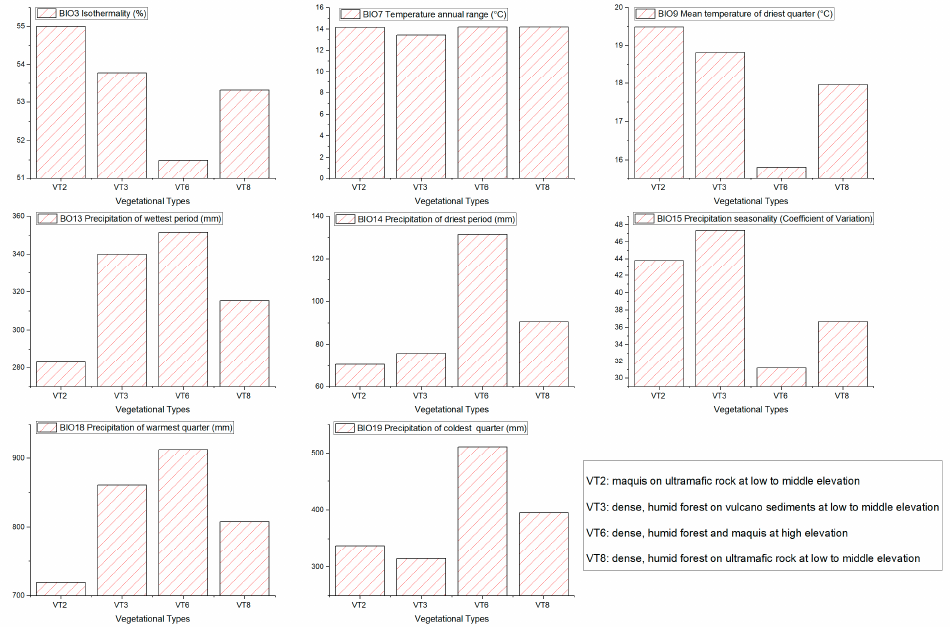
Figure 3. Relationship between bioclimatic variables and vegetation types of the occurrence localities of New Caledonian Arsipoda species.